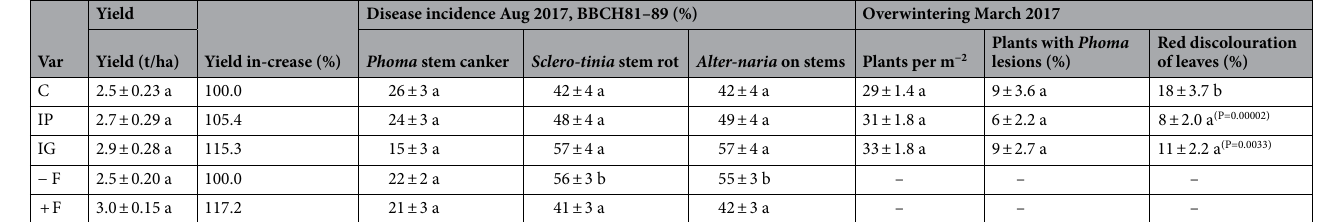
Table 2. Effect of bacterial endophytes applied as a seed coat on winter oilseed rape yield, Disease incidence of Phoma stem canker ( Phoma lingam ), Sclerotinia stem rot ( Sclerotinia sclerotiorum ), and Alternaria stem infection and on oilseed rape overwintering under commercial field conditions (Poříčí, Czech Republic). Data are presented as means ± SE. C = Control; IP = Serratia proteamaculans SP_RH21; IG = combined inoculum of Achromobacter piechaudii AP_RD9, Pseudomonas chloraphis/veronii PCh_RH1, P. grimontii/fluorescens PG_RD39 ( P. fluorescens clade), Stenotrophomonas sp. SS_RD24; − F = no fungicide treatment + F = fungicide treatment in spring. Where Dunnett test showed a significant treatment effect compared to the control C + the significance of this treatment effect is shown as P values in superscript brackets. Different letters indicate significant differences in nested factorial ANOVA (fungicide treatment) or Tukey HSD test nested within strip (bacterial seed